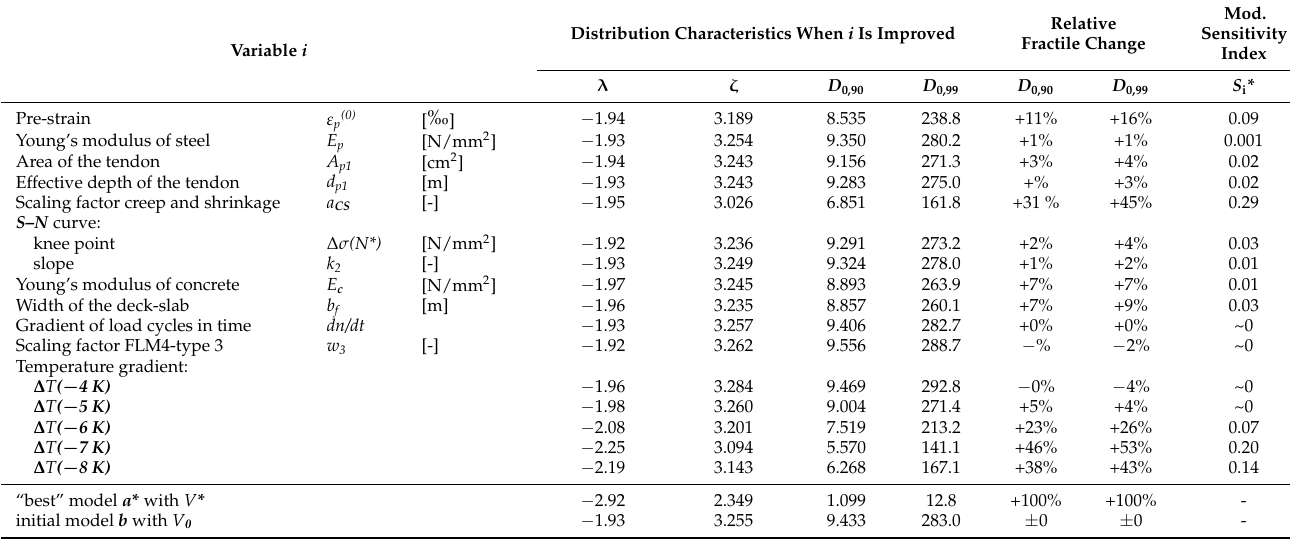
Table 2. Improved distribution parameters, specific improvements of the target variable and modified sensitivity indices. Table 1. Stochastic variables with initial (original) distribution characteristics ( μ i,0 , σ i,0 ) and reduced variances ( σ i * ), as well as Sobol’s sensitivity indices. Variable i